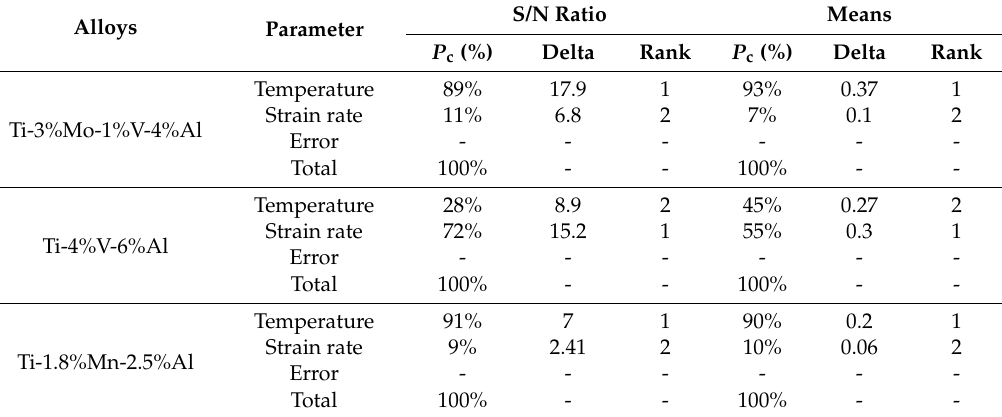
Table 7. Analysis of variance for the S/N ratios and the mean of the strain hardening/ softening coefficient.